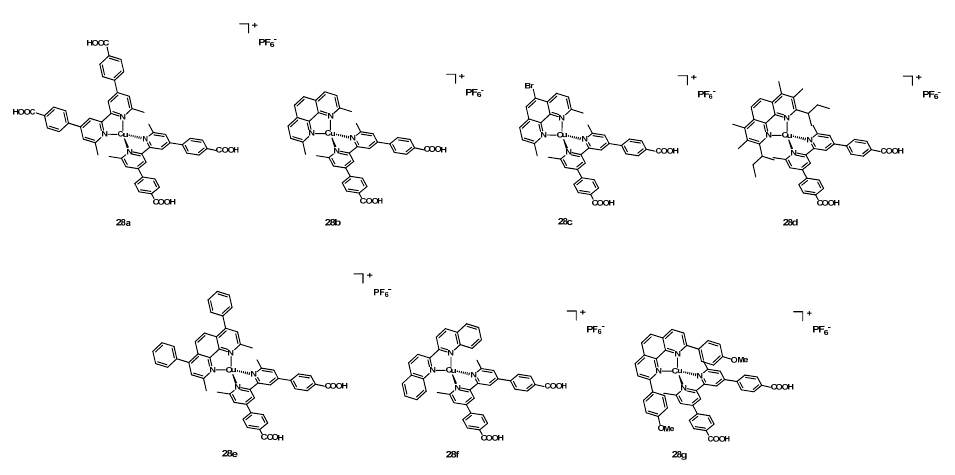
Figure 13. Structure of dyes 28a – g .